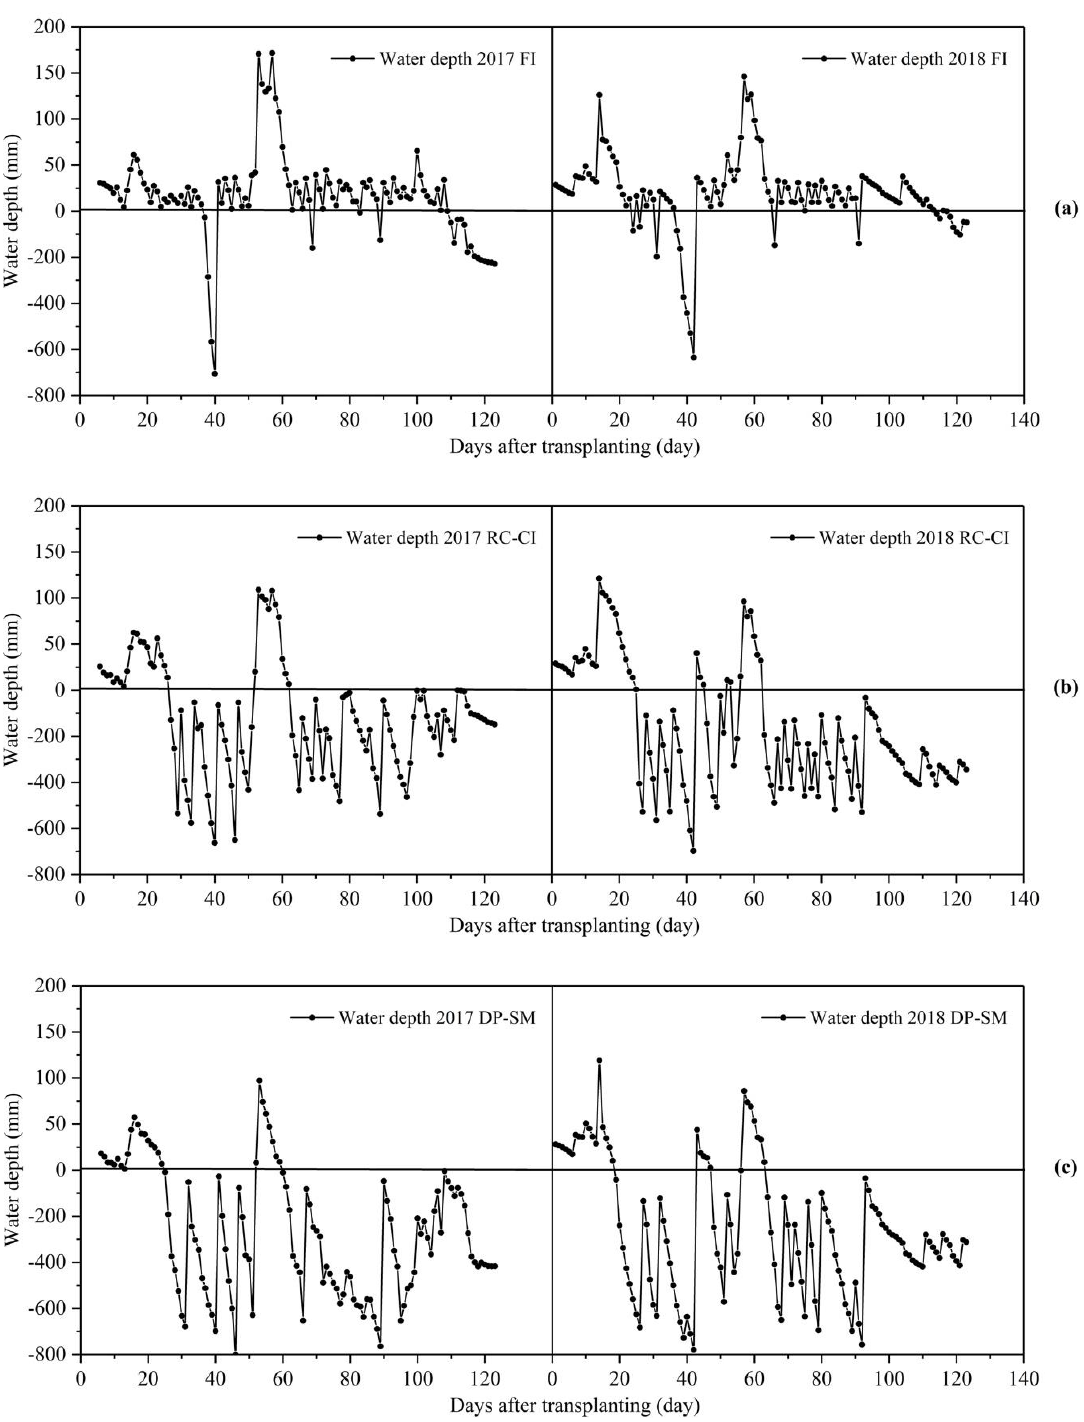
Figure 3. Water depths of FI ( a ), RC-CI ( b ) and DP-SM ( c ) during the rice growth season in 2017 and 2018.